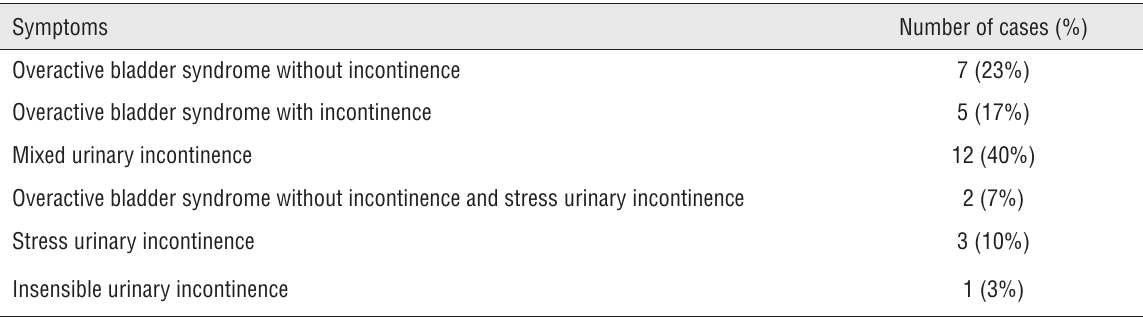
Table 1 - Main symptoms presented by 30 women eligible for urodynamic test